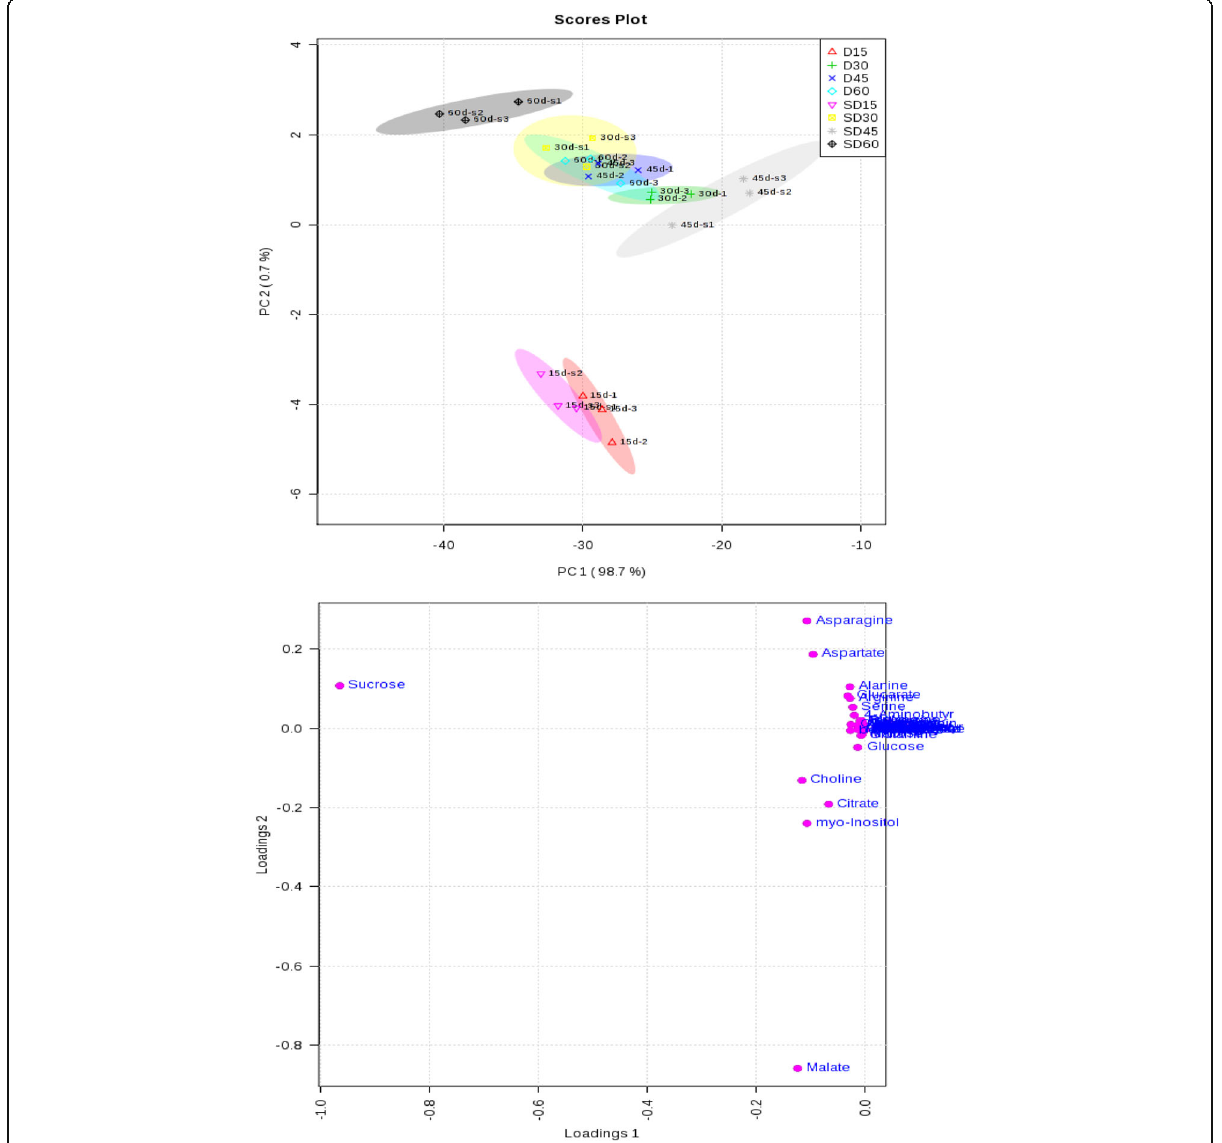
Fig. 1 Score and loading plots of effect of exogenous spermine on metabolite profiles of cold-stored immature vegetable